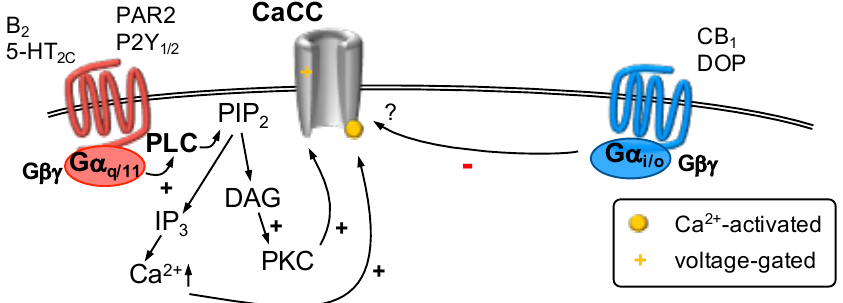
Figure 4. Calcium-activated Cl − channels (CaCC) are gated by increasing concentrations of cytosolic Ca 2 + and influenced by membrane voltage. The source of Ca 2 + may be Ca 2 + -permeable ion channels located in proximity to CaCCs (not shown) or Ca 2 + released from intracellular stores. Stimulation of G α q /11 -coupled receptors ( left ) activates phospholipase C (PLC). The subsequent hydrolysis of phosphatitylinositol 1,4, bisphosphate (PIP 2 ) forms inositiol 1,4,5 trisphosphate (IP 3 ) and diacylglycerol (DAG). DAG activates protein kinase C (PKC) which influences CaCC function. IP 3 binds to IP 3 receptors located in the membrane of the endoplasmic reticulum (ER) which causes Ca 2 + release from the ER. Activation of G α i / o -coupled receptors ( right ) was shown to decrease CaCC currents via an unknown